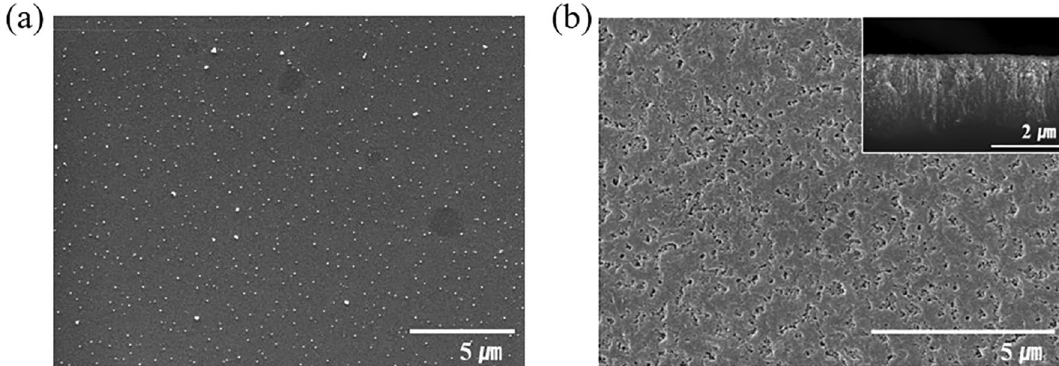
Figure 3. ( a ) SEM image of the electroless deposited Ag nanoparticles on the exfoliated flexible Si film, ( b ) SEM image of the porous Si surface formed by an Ag-assisted chemical etching process (inset: cross-sectional view of the porous Si surface).